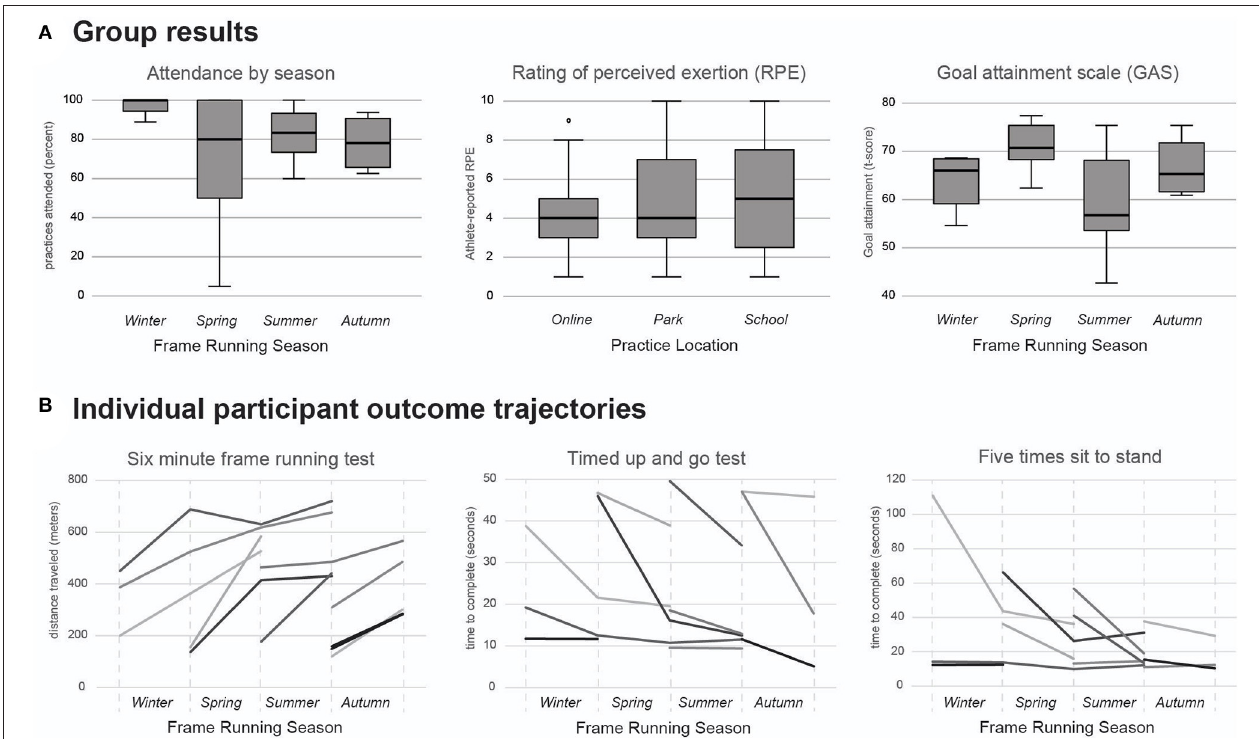
FIGURE 2 | (A) Group summary box and whisker plots. The practice attendance percentage is calculated by dividing the number of practices attended by the total number for a season. This panel includes all 8 athletes that began the spring season. There was a significant main effect of location found in the Kruskal–Wallis test of RPE ( H = 42.38, p < 0.001), where park and school were both significantly higher than online; the median (shown in thick black in plot) of home was four, park was four, and school was five. GAS t -scores are calculated to combine each athlete’s overall goal attainment within a season; with coaching and support from researchers, athletes set 2–4 goals each season. (B) Individual data trajectories shown for performance-based outcome measures. Each line represents a different participant. For reference, the normative TUG for 5–13 year old youth ranges from 6.20 to 7.12s ( Itzkowitz et al., 2016), and the 5xSTS for 14–19 year old youth is 6.5s, with a standard deviation of 1.2s (Bohannon et al.,